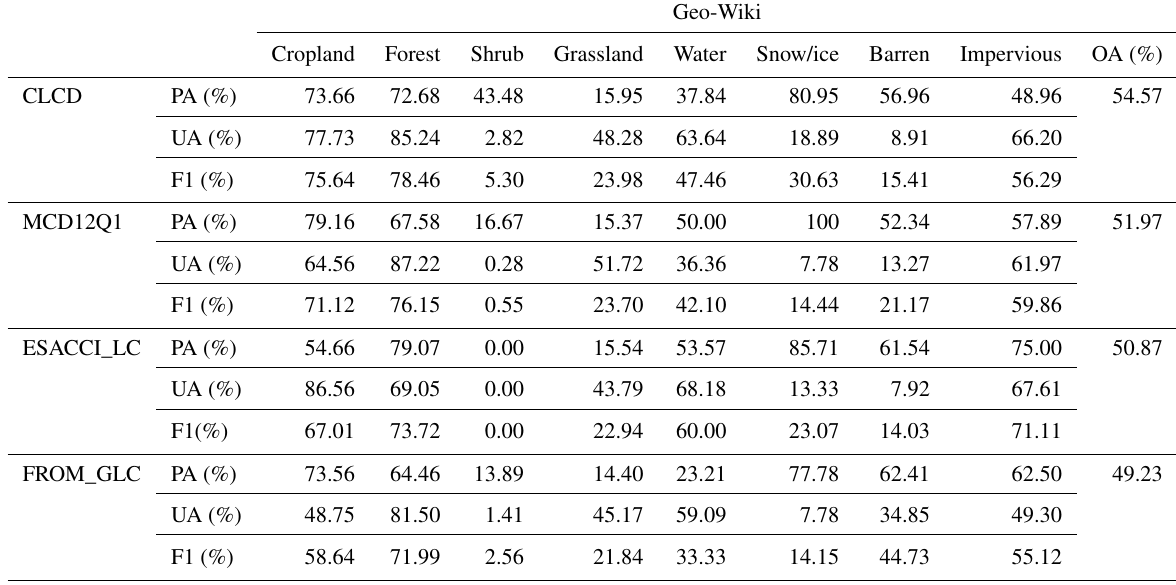
Table 2. Comparison of mapping accuracy based on Geo-Wiki test samples for ESACCI_LC, MCD12Q1, FROM_GLC and CLCD ∗ .